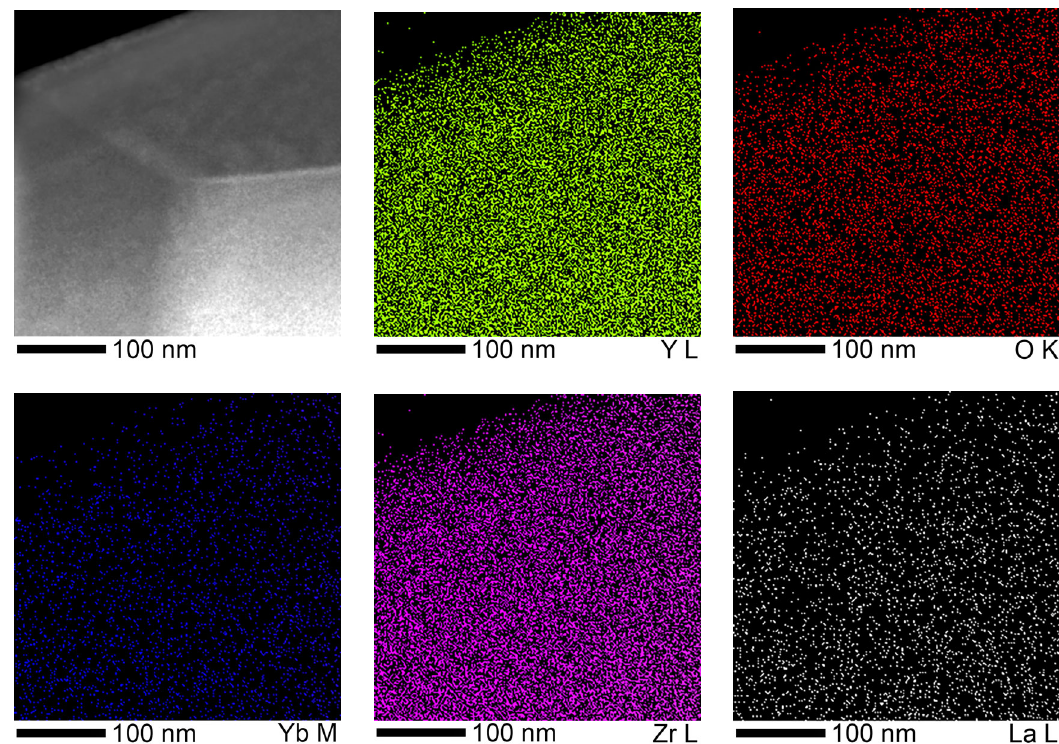
Fig. 10 STEM image and elemental mapping of (Y 0.93 Yb 0.05 La 0.005 Zr 0.015 ) 2 O 3 ceramics sintered at 1800 ℃ for 10 h.